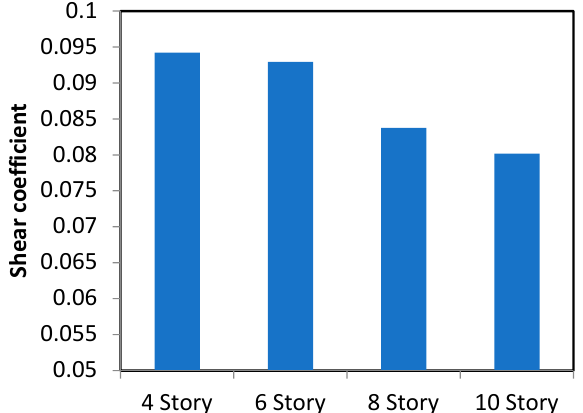
Figure 6. Comparative base shear coefficient of selected buildings.